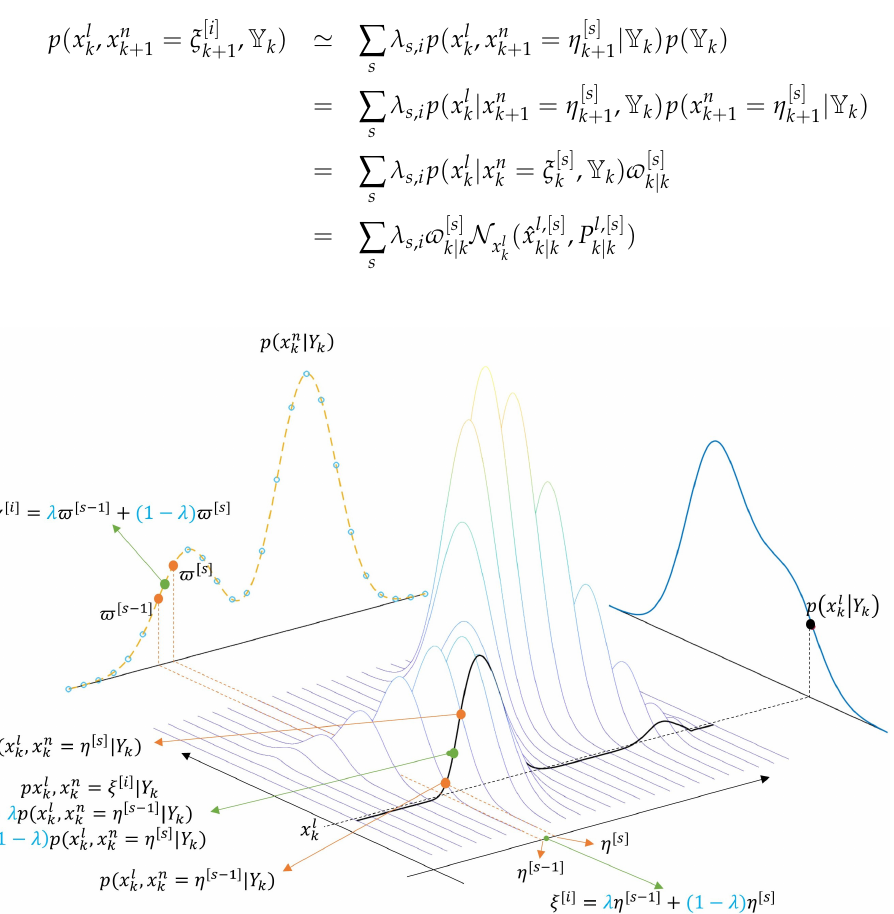
Figure 8. Concept of the approximation of the joint probability of the nonlinear part and the linear part by the linear interpolation in